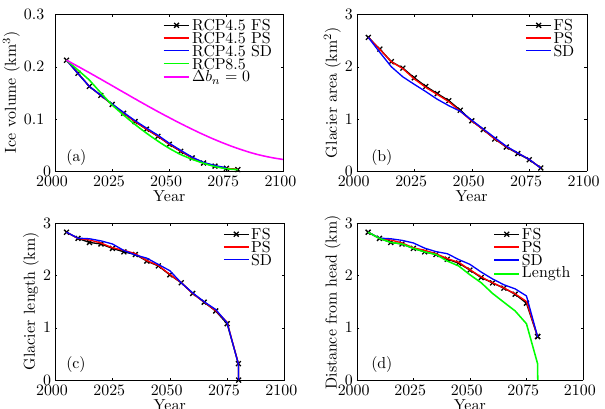
Fig. 11. 21st century evolution of Haig Glacier under RCP emission scenarios. (a) Evolution of ice volume under RCP4.5 and RCP8.5. For comparison, the result for a no-change scenario is also shown. Evolution of (b) areal extent, (c) glacier length, and (d) terminus position under RCP4.5 scenario. “Length” in (d) is the FS solution shown in (c) .